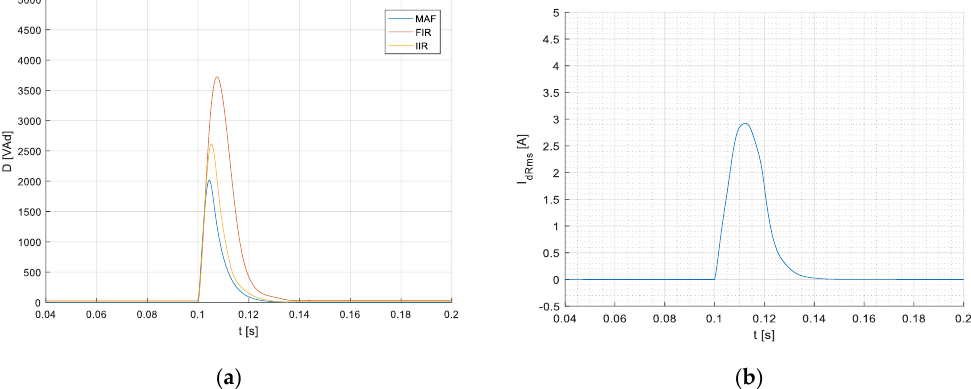
Figure 12. Waveforms of distortion power components 𝐷 𝑎𝑣 (𝑘) during transient states calculated by different methods (MAF-, DFIR, and DIIR filters) ( a ), and the corresponding deformation compo- nent of the current using the MAF method ( b ).